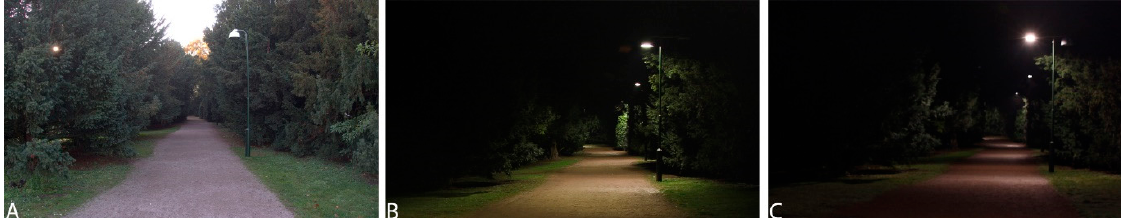
Figure 1. Pedestrian path during the day ( A ) and at night, for lighting application I ( B ) and II ( C ) (ISO 100, f/4, exposure time 1.3 s).